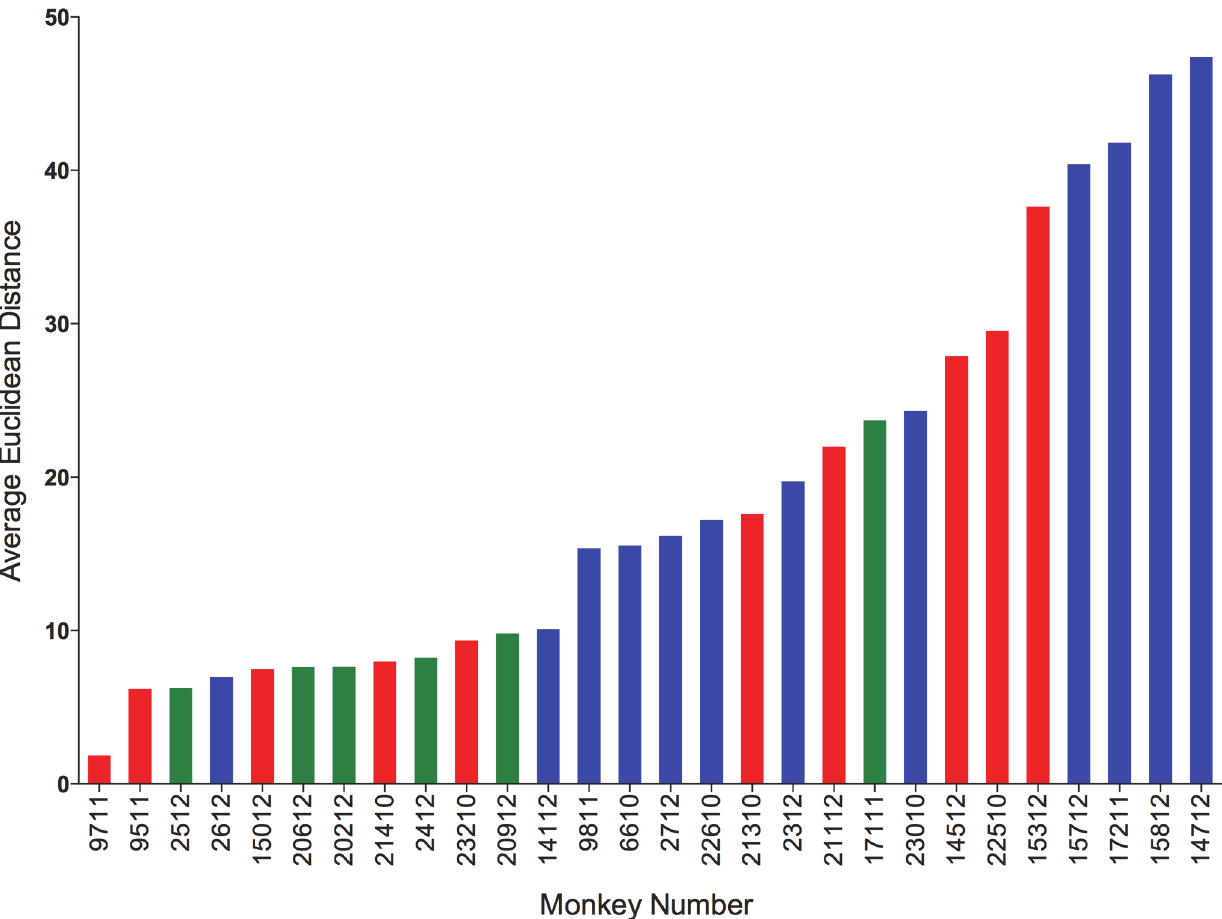
Figure 9. Systemic and local T cell responses. Euclidean distance between T cell cytokines from blood (systemic) and each of the individual granulomas (local) of animal were calculated. The distances were averaged per animal and represented as the average Euclidean distance. Average Euclidean distance provides an estimate for “ relatedness ” between the systemic T cell response and local T cell response. Each bar represents an animal. Animals with active disease are represented in red, latent infection in blue and those infected for * 11 weeks in green. Animals are arranged in increasing average Euclidean